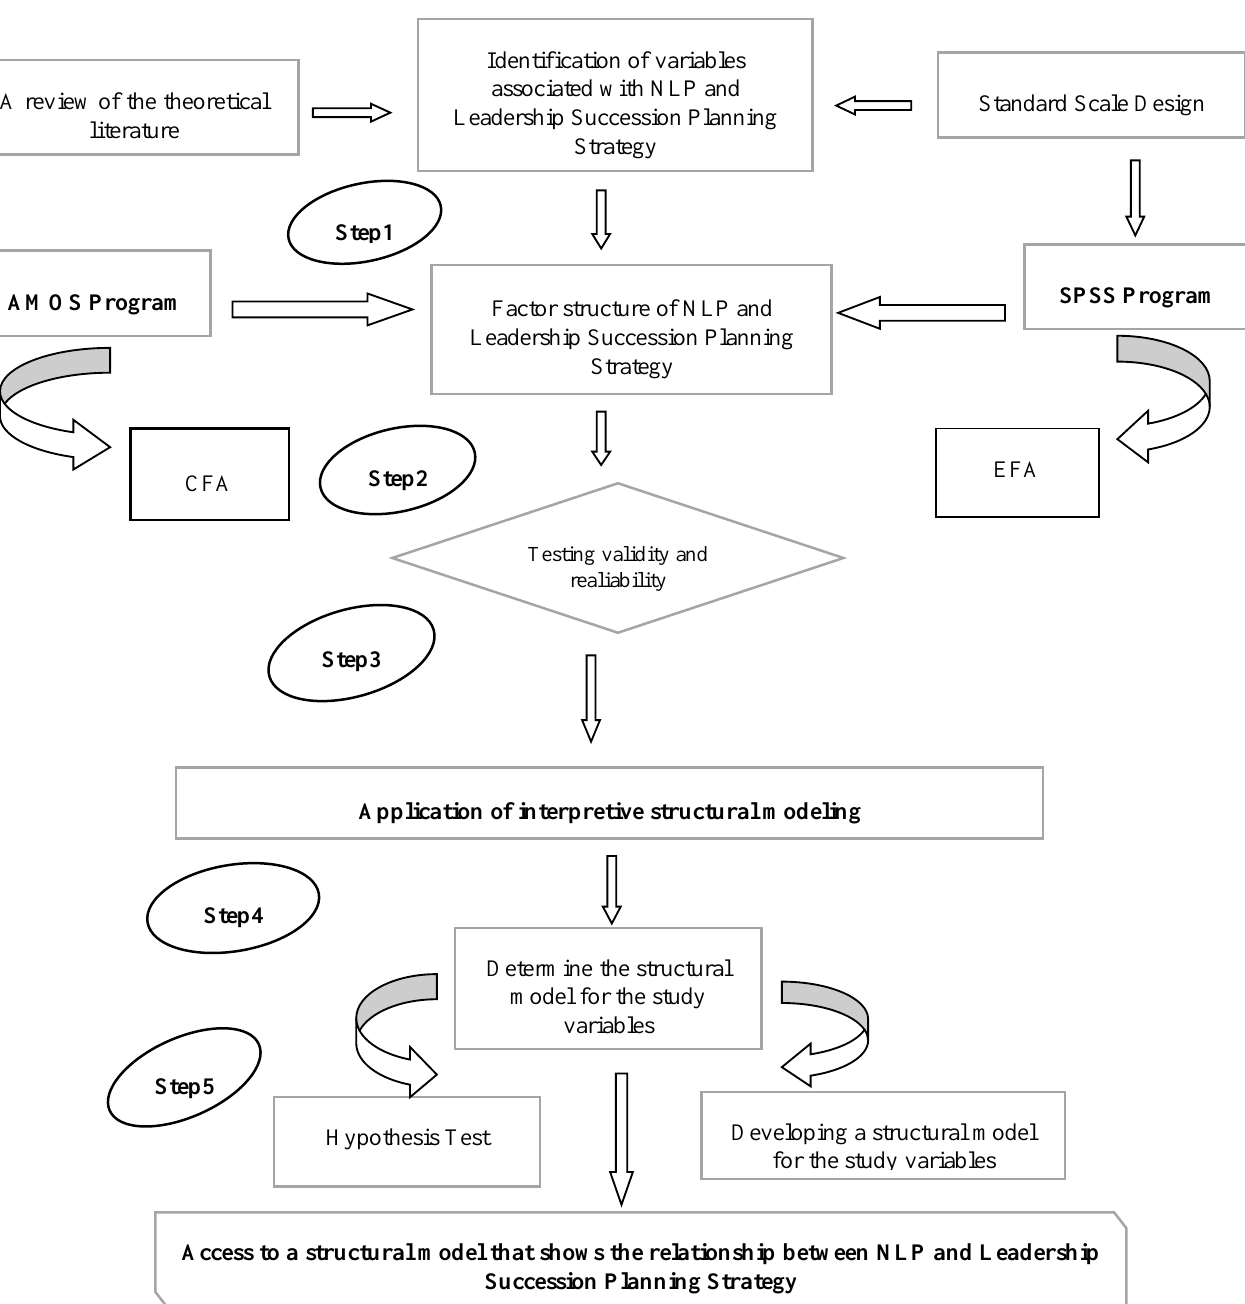
Figure 7. The Methodological Steps of FA-ISM-SEM for Systematizing the Relationship Between NLP and Leadership Succession Planning